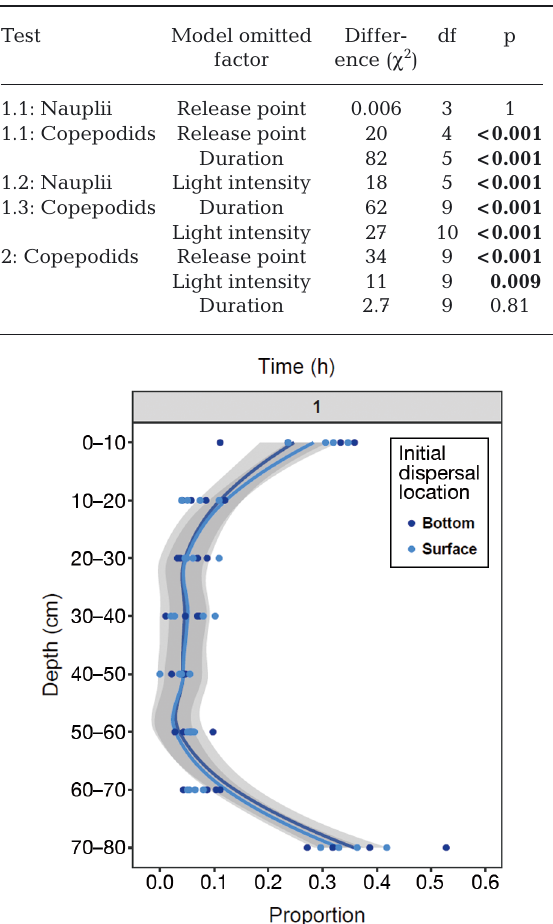
Table 2. Generalised additive model comparison of maximum likelihood for the vertical distribution of Lepeophtheirus salmonis nauplii and copepodids. A null model (selected fac- tor omitted) was compared against the full-factored model for